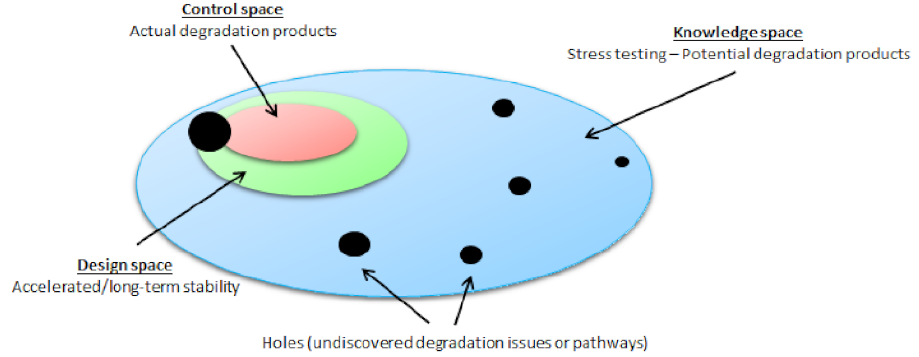
Figure 2. Conceptual diagram of quality by design, showing the relationships between the knowledge space, design space, and control